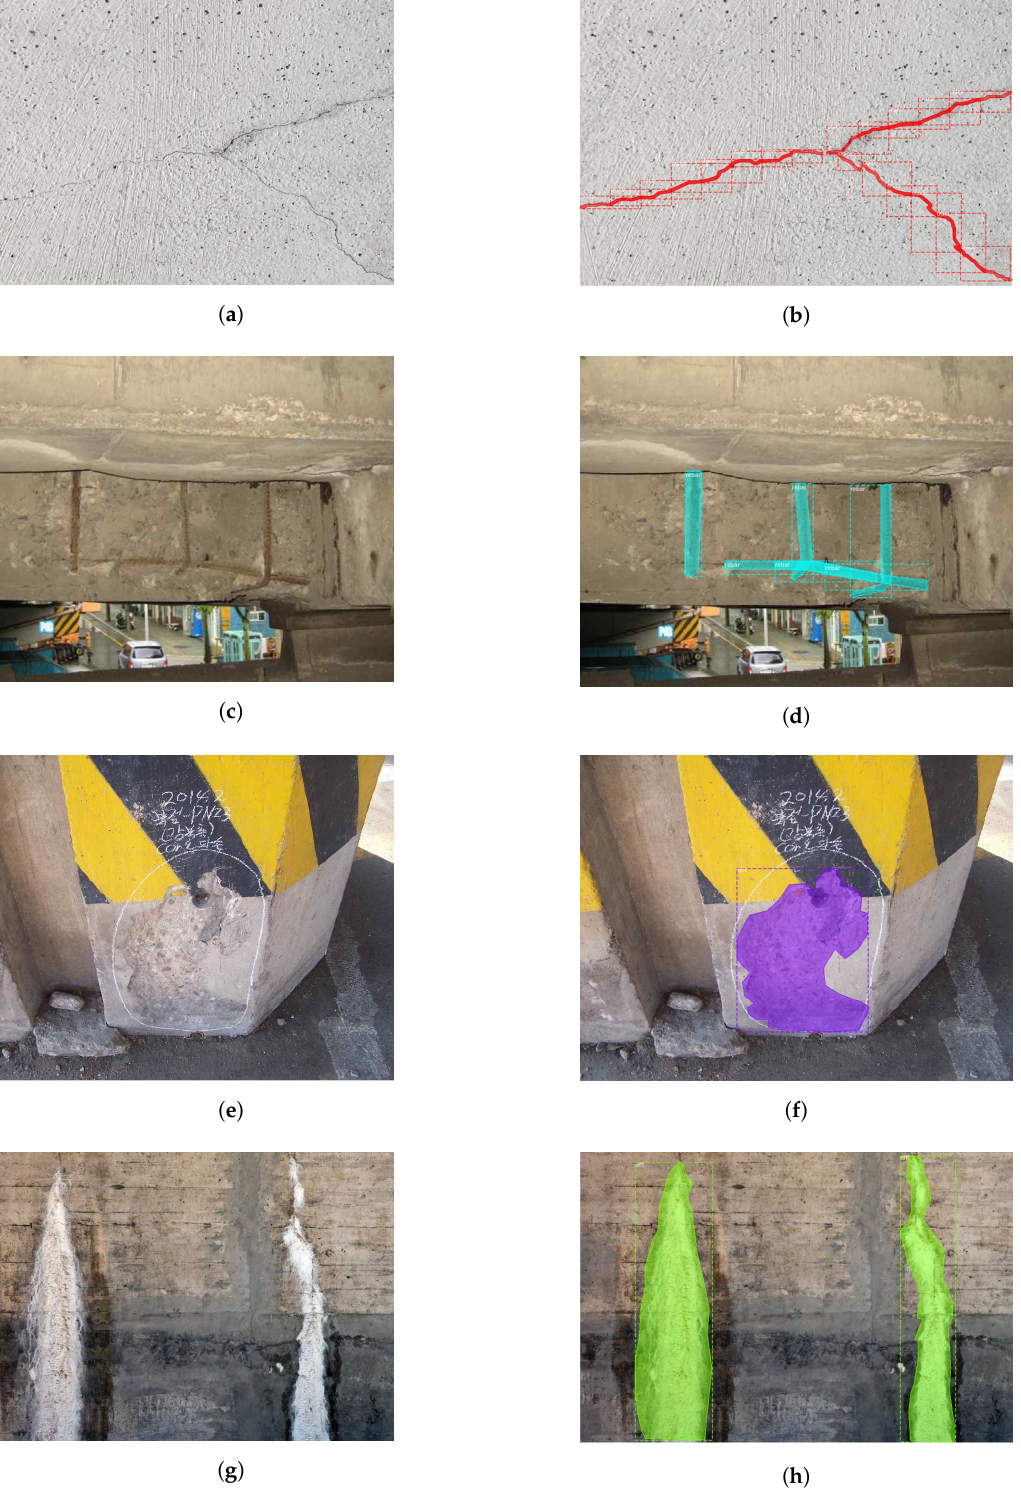
Figure 3. Examples of original training images (left column) and damage annotation (right column): ( a , b ) crack, ( c , d ) rebar exposure, ( e , f ) spalling, and ( g , h )